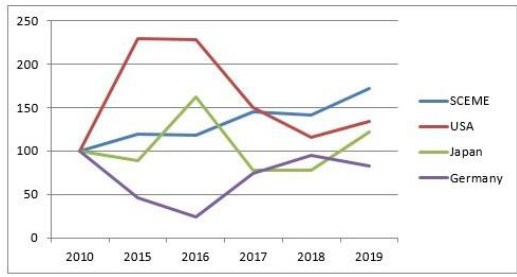
Figure 3. Rate of Foreign direct Investments SCEME: without Uzbekistan, Azerbaijan, Belarus, Armenia, Kazakhstan